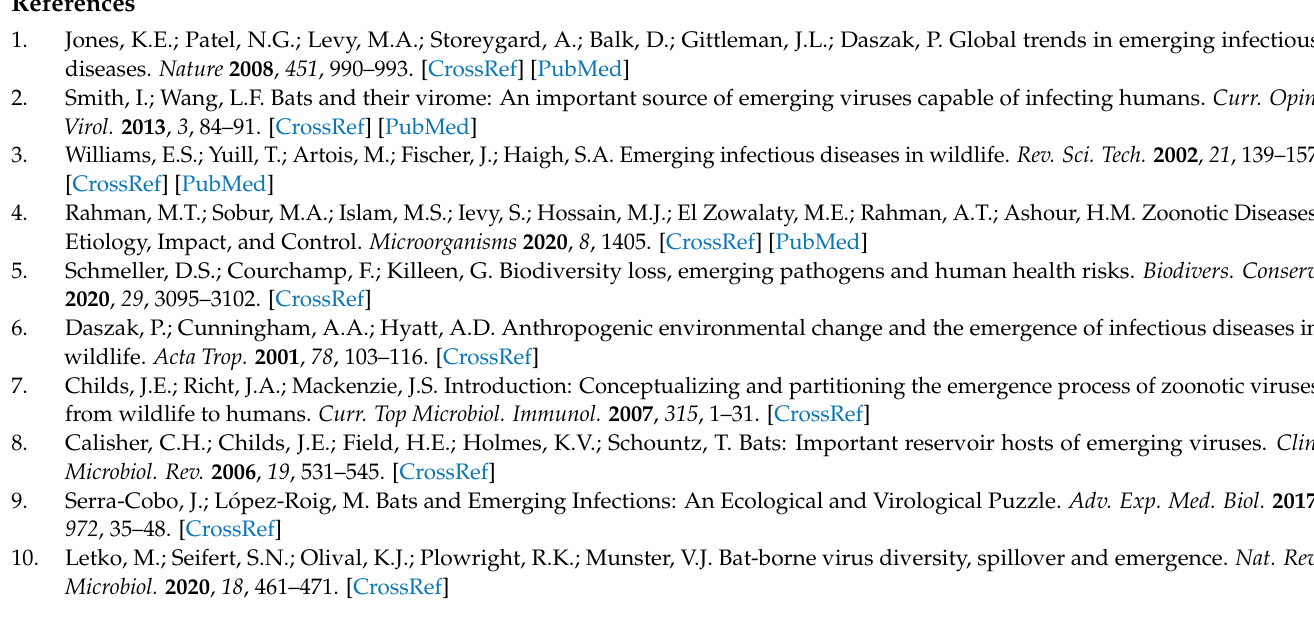
Table S2: The primer pairs used for sequencing of the spike protein locus of the MERS-related CoVs from the Aargau colony including the expected product